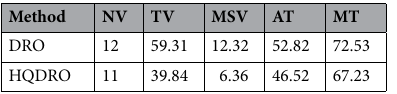
Table 6. Comparison of DRO and